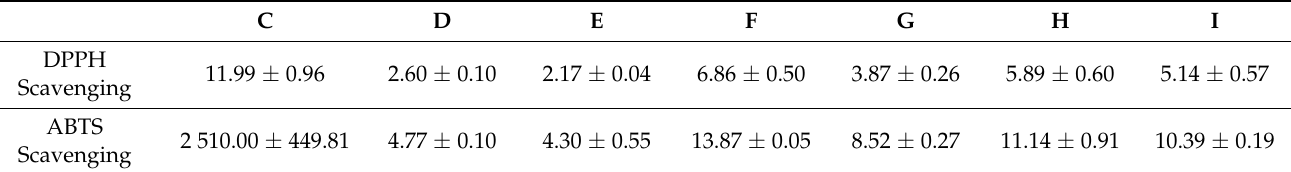
Table 5. DPPH and ABTS scavenging activity of C-I fractions of flower buds extract (R3) of R. platyacantha (IC 50 , µ g/mL ± SD); each value represents mean ± SD ( n = 3).